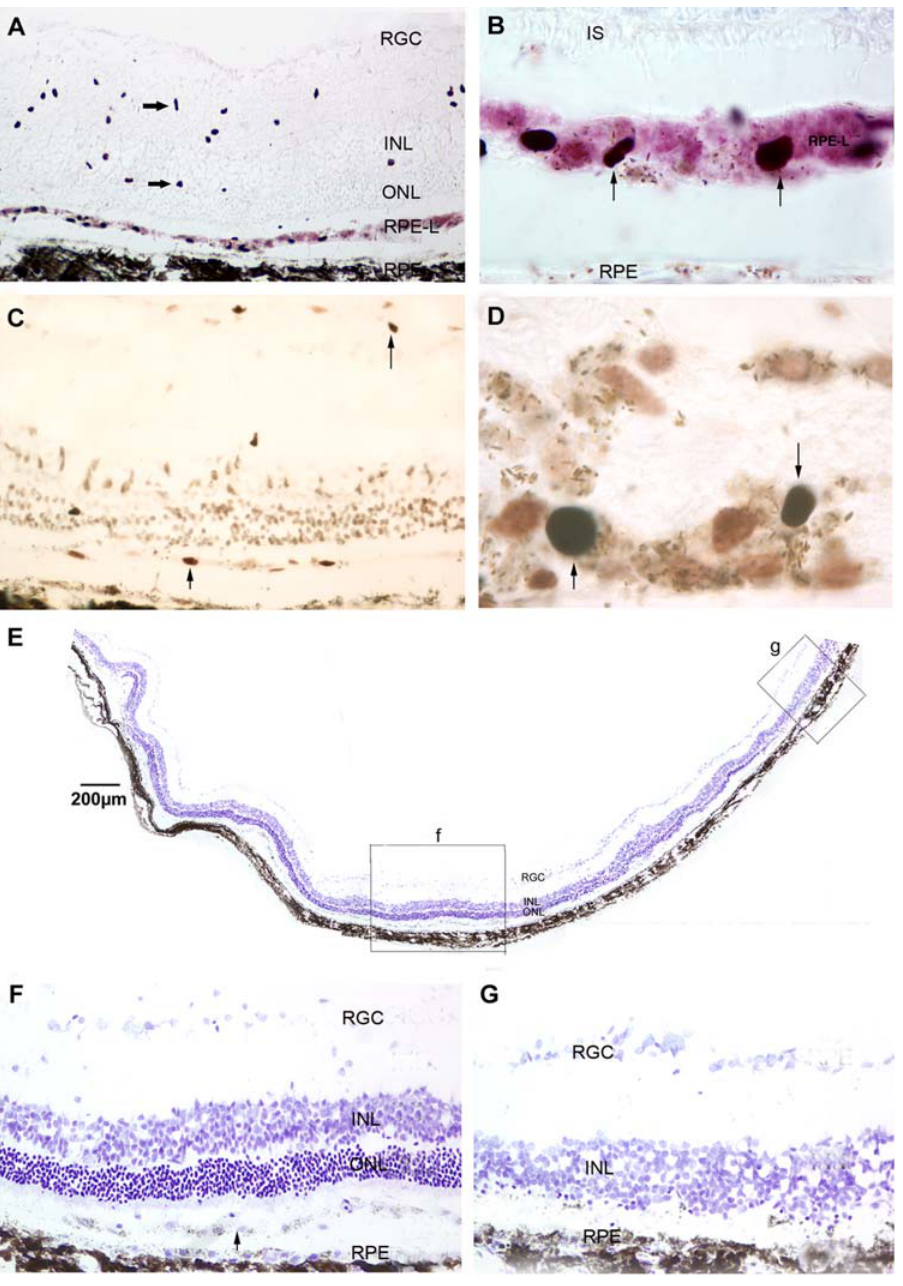
Figure 5. Human neural progenitors survive as two distinct populations within the retina and promote photoreceptor rescue. (A) Retinal section obtained from a P150 eye immunostained with human-specific nuclear marker. There is a pigmented RPE-like (RPE-L) layer of donor cells above the host RPE layer, whereas donor cells in the inner retina do not have pigment granules ( right-pointing arrows ). (B) High power image showing pigment granule- containing donor cells in the RPE-L region that are positive for human nuclear marker ( arrows ). Photoreceptor inner segments (IS) are visible above the pigmented donor cell layer, demonstrating partial preservation of photoreceptor structure. (C) Retinal section from the same eye used in panel A stained with proliferating cell nuclear antigen (PCNA) revealing occasional dividing cells in the RPE-L layer and inner retina at P150 ( arrows ). (D) High power image showing PCNA-positive cells in the RPE-L layer ( arrows ). (E) Low power view of a retina section obtained from the same eye used in panel A showing extensive rescue of photoreceptors within the outer nuclear layer (ONL) after subretinal injection of hNPC ctx –GDNF. The boxes labeled f and g correspond to the high power images depicted in panels F and G, respectively. (F) High power view of box f from panel E showing rescued ONL and the underlying, semi-continuous layer of donor cells between the photoreceptors and RPE ( arrow ). (G) High power view of box g from panel E showing non-rescued ONL distant from surviving subretinal donor cells. INL: inner nuclear layer; IS: inner segments; ONL: outer nuclear layer; RGC: retinal ganglion cell layer; RPE-L: RPE-like layer.